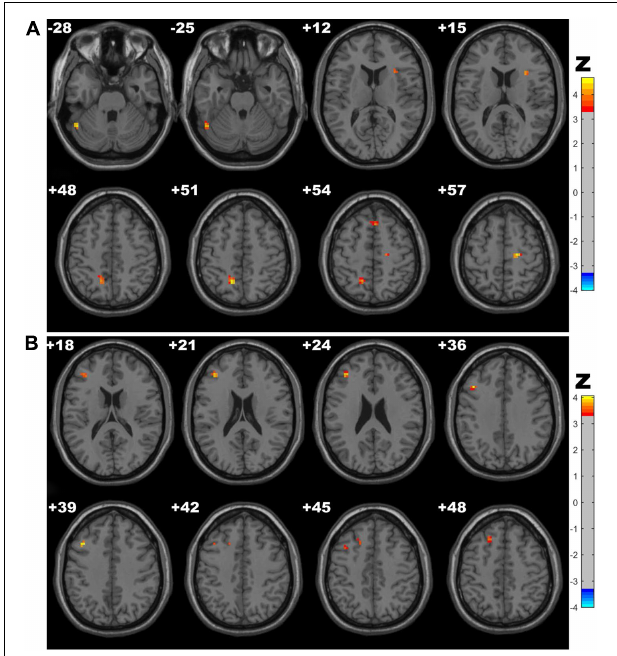
FIGURE 3 | Clusters with significantly altered ReHo values among groups (ANOVA and LSD post hoc test with GRF correction, voxel-level p < 0.001, cluster-level p < 0.05). The red-yellow areas denote higher ReHo values in the CSVD-c group than in the (A) control groups or (B) CSVD-n group.